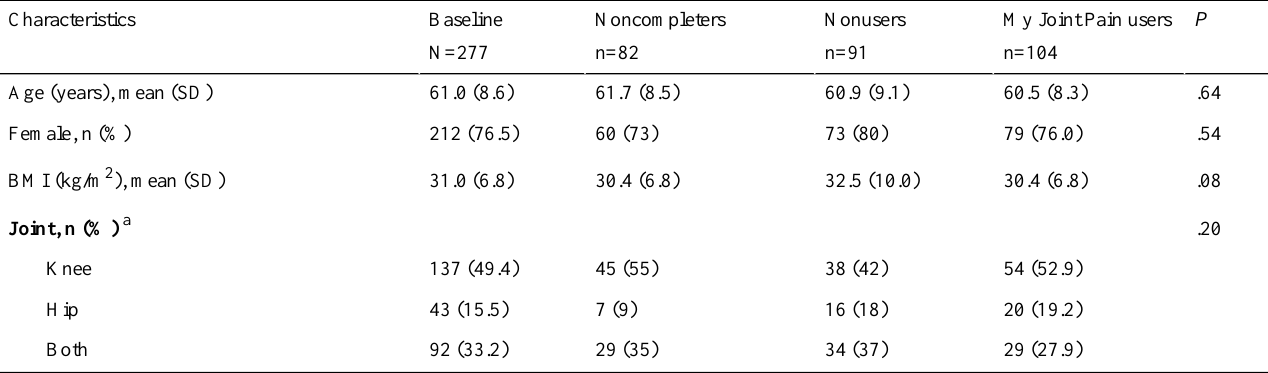
Table 1. Demographic characteristics of participants at baseline (N=277).